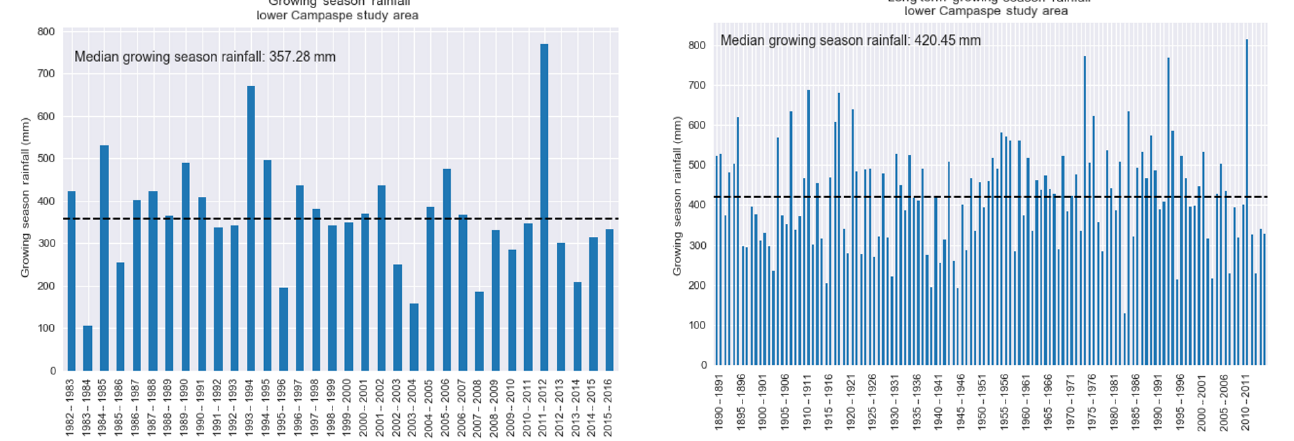
Figure 4. Growing season rainfall over the 1982–2015 growing seasons. Median growing season (dashed black line) was found to be 357.28mm, below the usual growing season rainfall of 420mm (see Fig. 5 below).